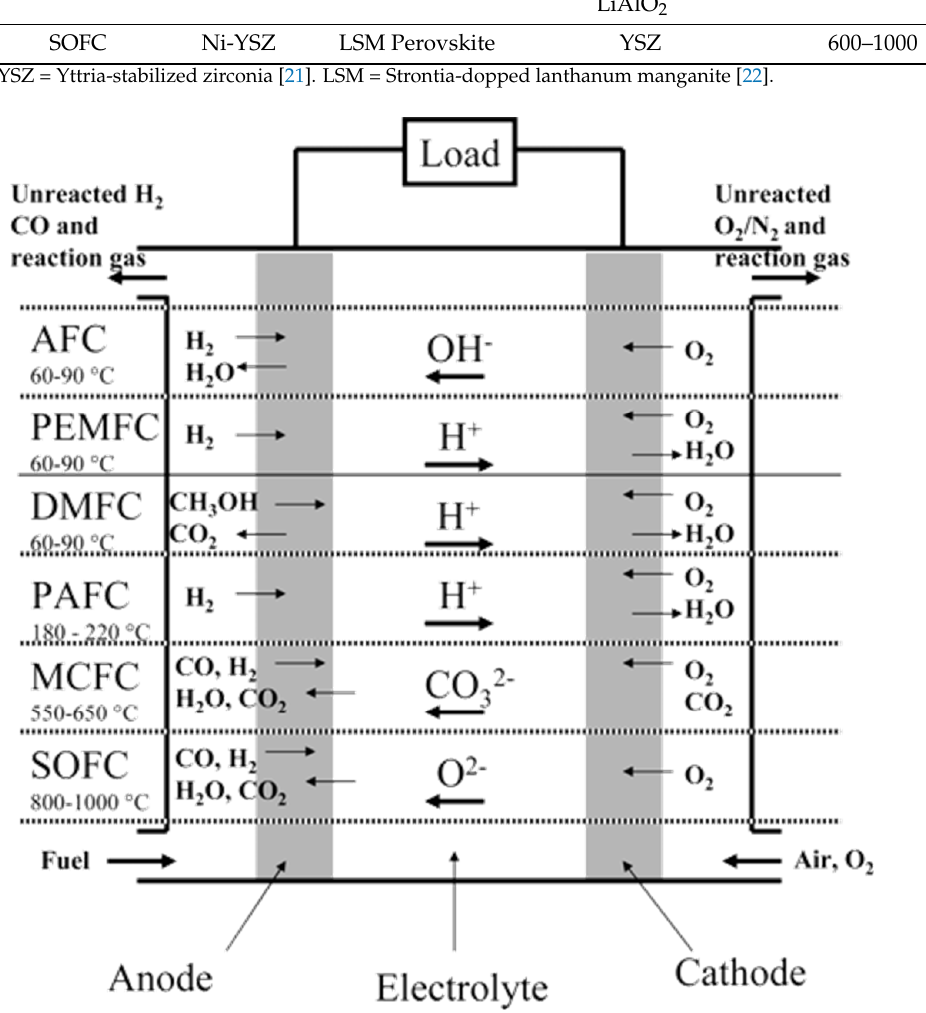
Figure 3. Schematic diagram of electrochemical reactions occurring in various FCs [20]. Table 1. Characteristics of various FC systems [20].